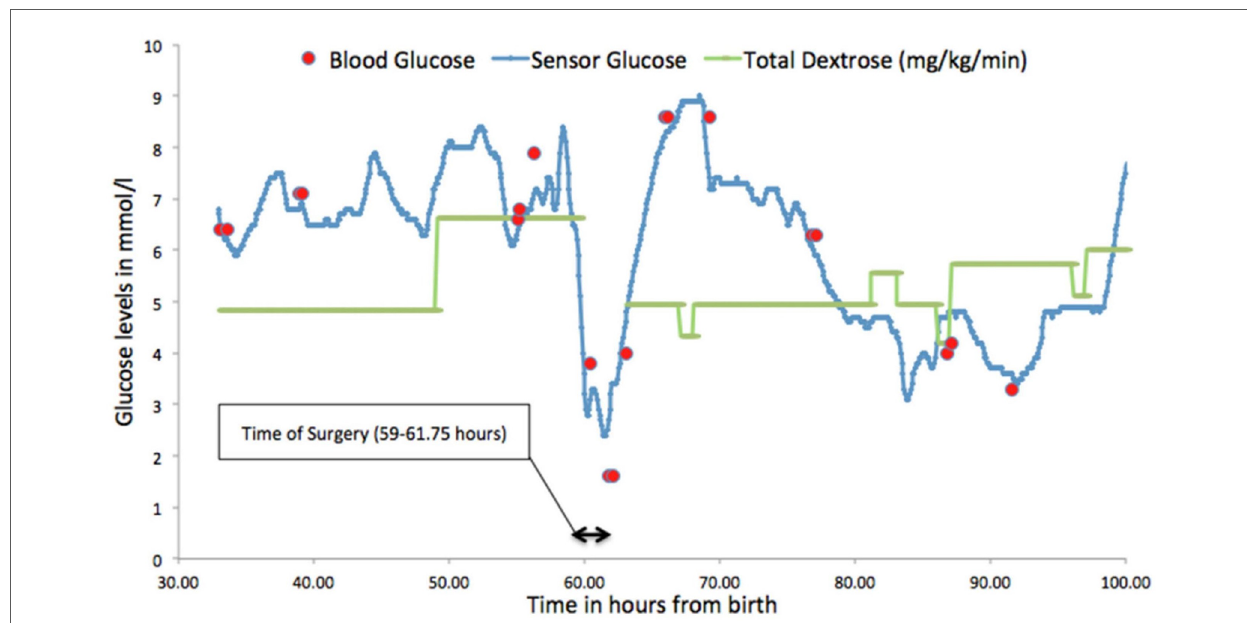
FIGURE 3 Glucose pro fi le demonstrating fl uctuating glucose levels in a neonate during surgery for necrotising enterocolitis. Figure reproduced with permission from Saha P, Beardsall K Perioperative continuous glucose monitoring in a preterm infant. Case Reports 2018; 2018: bcr-2018 –